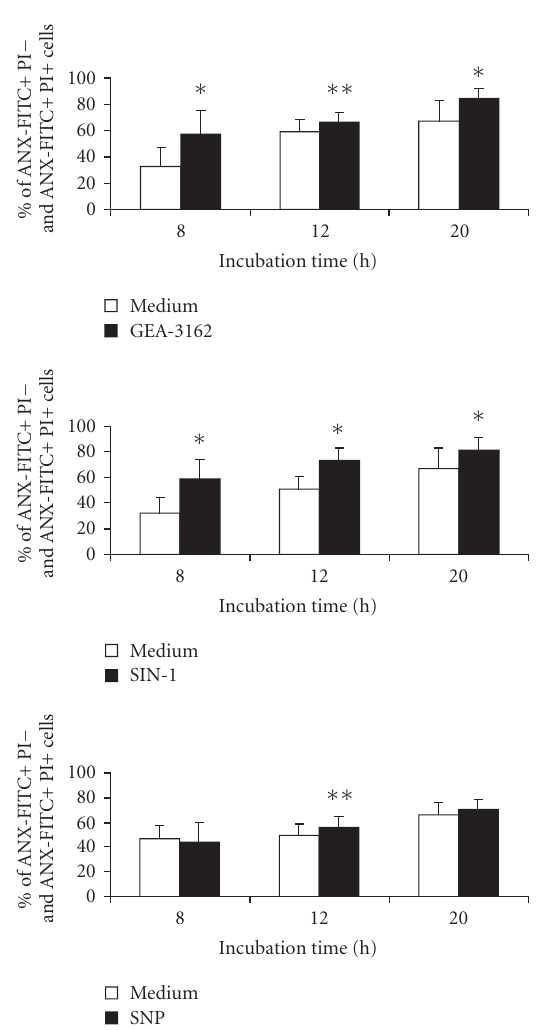
Figure 1. E ff ect of NO donors on neutrophil apoptosis in vitro measured by ANX-FITC and PI binding. Neutrophils (1 × 10 6 cells) were incubated in the absence (control cell samples) (open bars) or presence of 10 µ M of GEA-3162, 1mM of SNP, and 1mM of SIN-1 at 37 ◦ C (closed bars) for 8, 12, and 20hours and apoptosis was determined as described in “materials and meth- ods.” Data are given as means and SD percentages of the sum of cells binding ANX-FITC+PI − and ANX-FITC+PI+ for 9 sepa- rate experiments. Statistical significance: neutrophils versus neu- trophils with nitric oxide donors ( ∗ denotes that P ≤ . 005, ∗∗ denotes that P ≤ . 05).